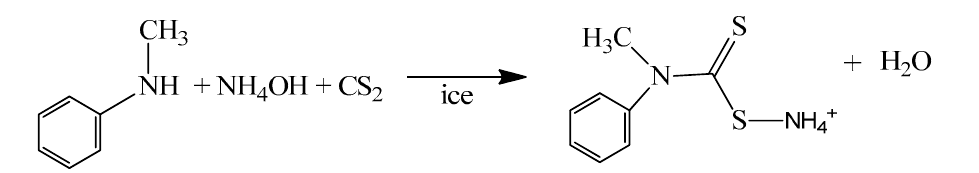
Figure 2. Mechanism of N -methyl- N -phenyl dithiocarbamate ligand formation.